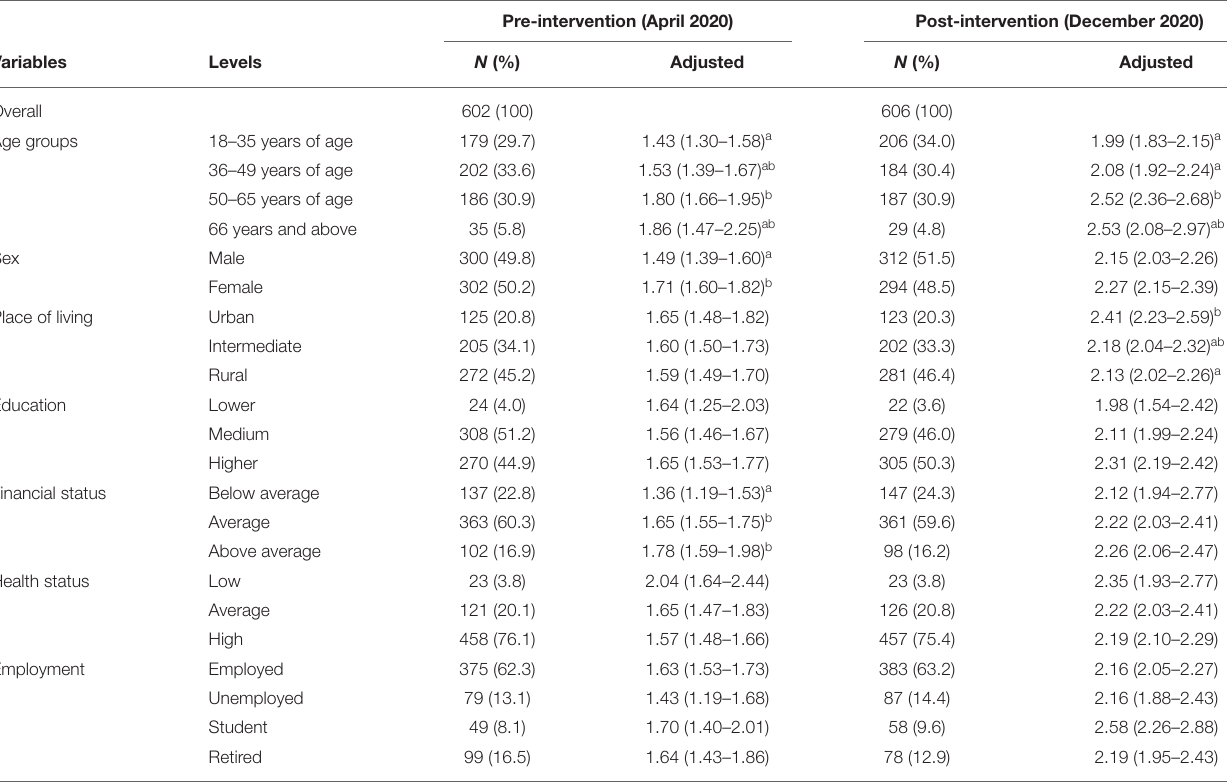
TABLE 3 | Pre-intervention ( N = 602; April 2020) and post-intervention ( N = 606; December 2020) adjusted mean (95% CI) levels of vitamin D-related knowledge by age, sex, place of living, education, financial status, health status, and